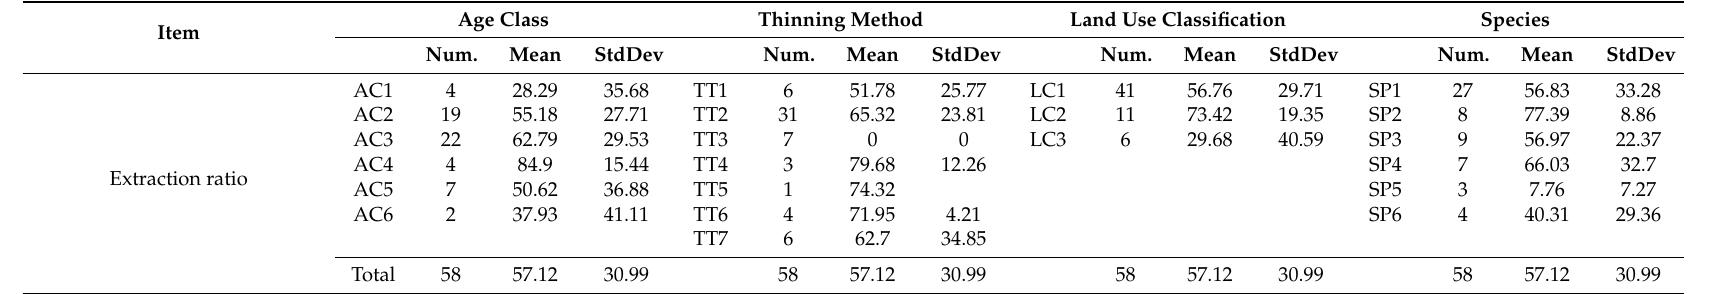
Table 6. Relationships between site/species attributes and extraction